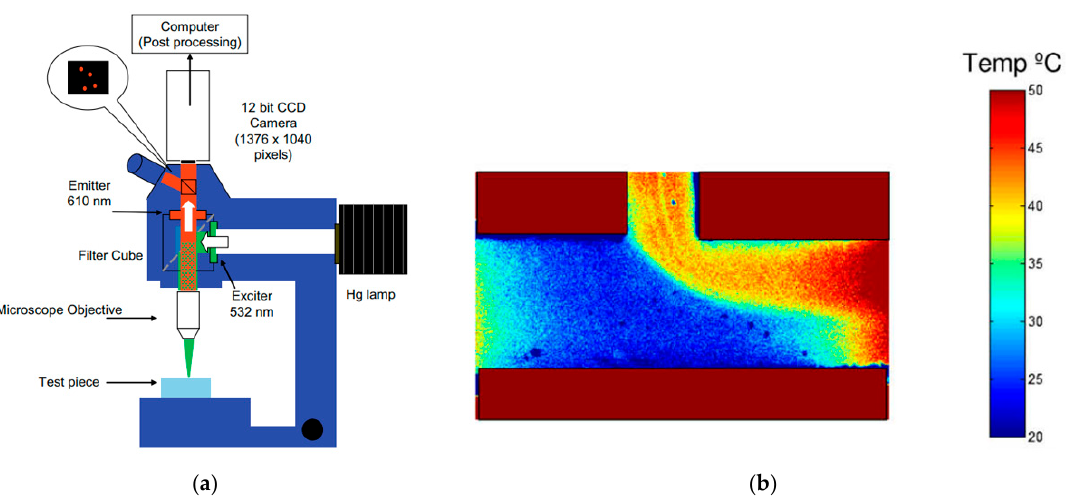
Figure 42. ( a ) μ LIF thermometry experimental setup from Chamarthy et al. [197]; ( b ) temperature measurements in a T-junction. Reprinted by permission from Ref. [197], International Journal of Heat and Mass Transfer, Copyright © 2022 Elsevier Ltd.